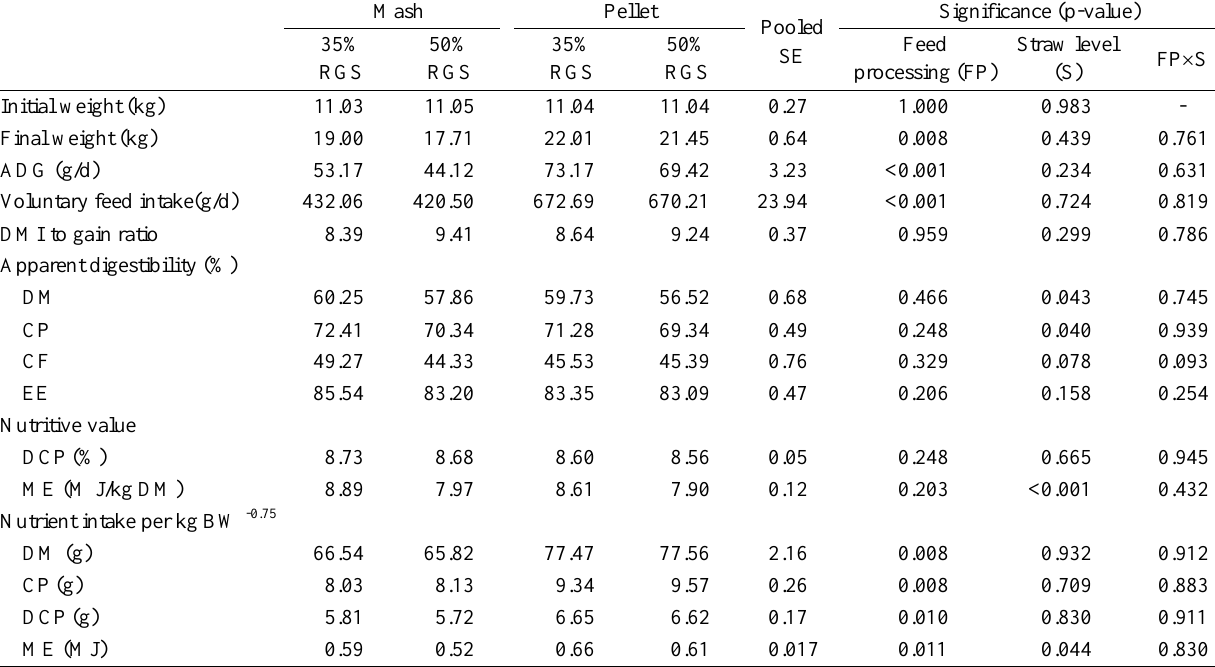
Table 2. Weight gain, voluntary feed intake, nutrient digestibility and nutrient intake by goats on experimental feeds